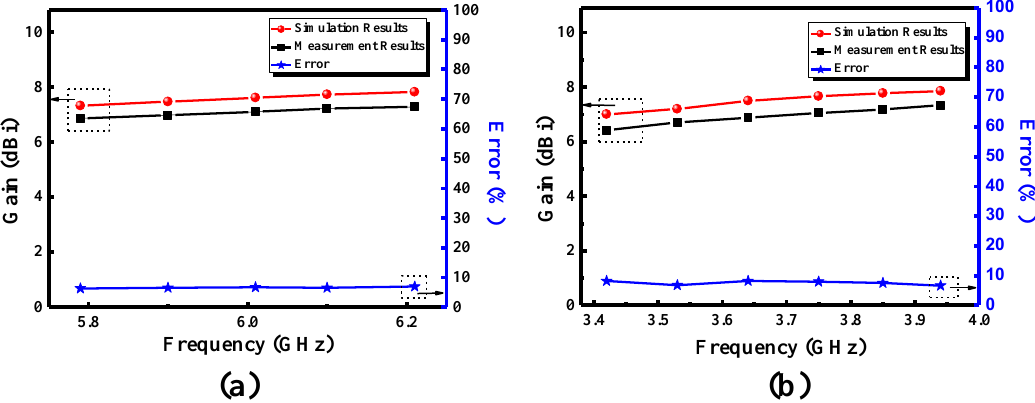
Figure 8. ( a ). Simulated and measured gains of the antenna (four smaller side patches are all connected to the larger main patch). ( b ). Simulated and measured gains (one smaller side patch is connected to the larger main patch).